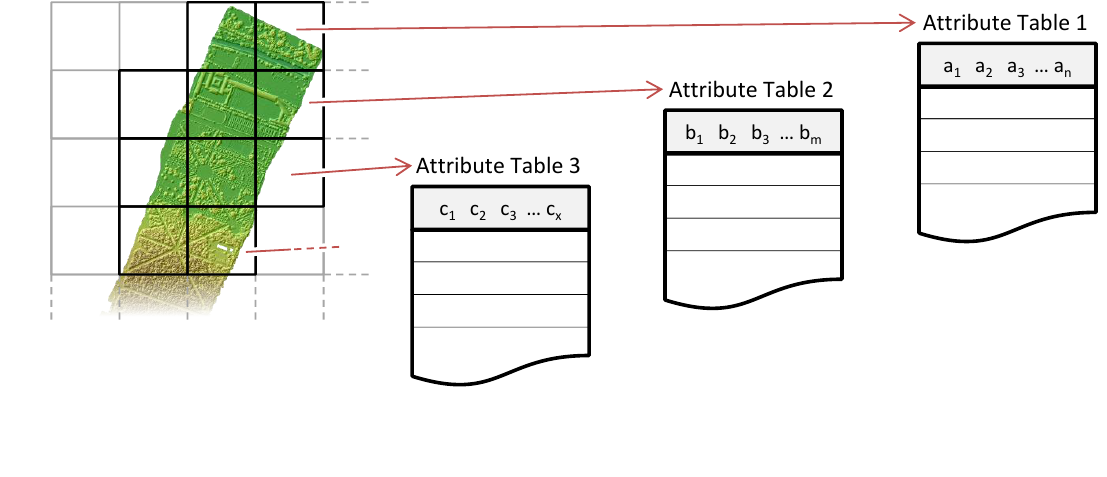
Figure 5. Separate attribute tables for each spatial index leafs (tiling index, in this